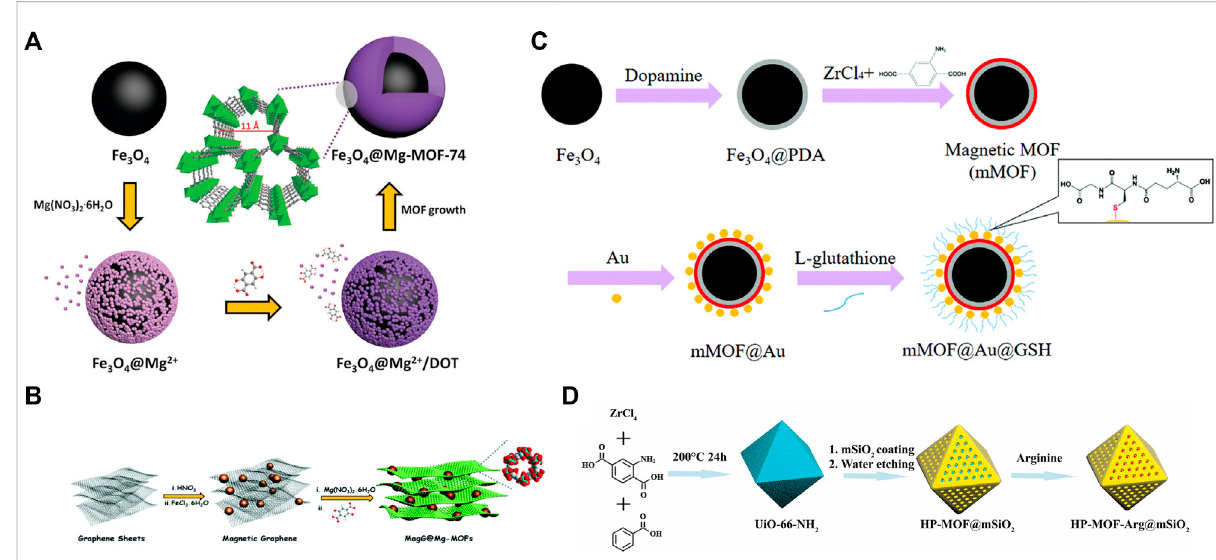
(C) The synthetic procedure for mMOF@Au@GSH. Reproduced from (Liu et al., 2018) with permission from Royal Society of Chemistry. (D) Schematic of the synthesis of HP-MOF-Arg@mSiO 2 nanomaterials. Reproduced from (Zhu et al., 2022) with permission from